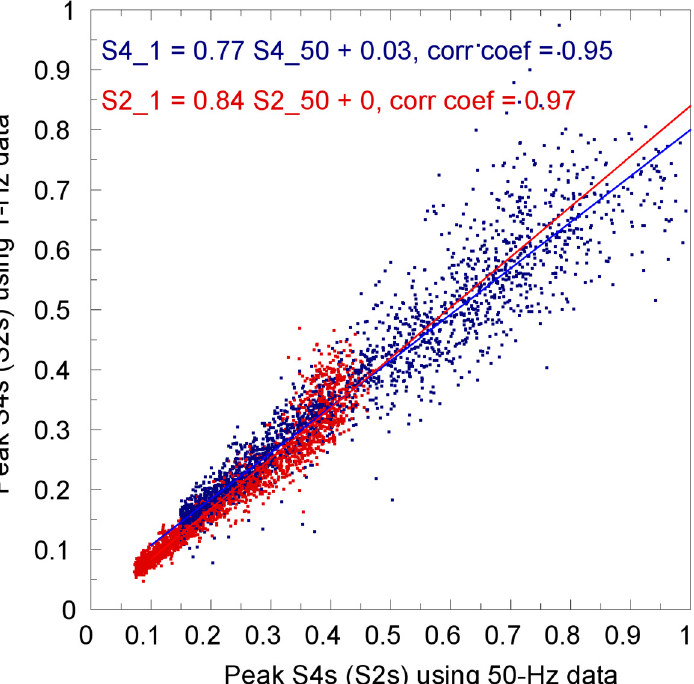
Figure 7. Scatter plot for the peak S 4 ( S 2 ) values measured using 1 Hz data versus the peak S 4 ( S 2 ) values measured using 50 Hz data is shown in blue (red). Two corresponding least-squares fitting lines, line equations, and the obtained correlative coefficients are also shown. The experimental FS3/COSMIC data were obtained on 1 January and 1 July 2007.